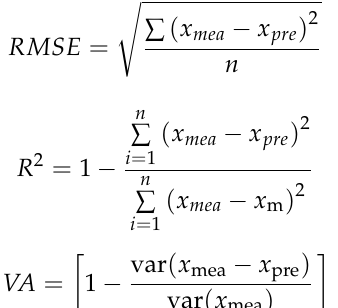
Figure 8. Comparison between measured and predicted AR from ANFIS model: ( a ) training set and ( b ) testing set.